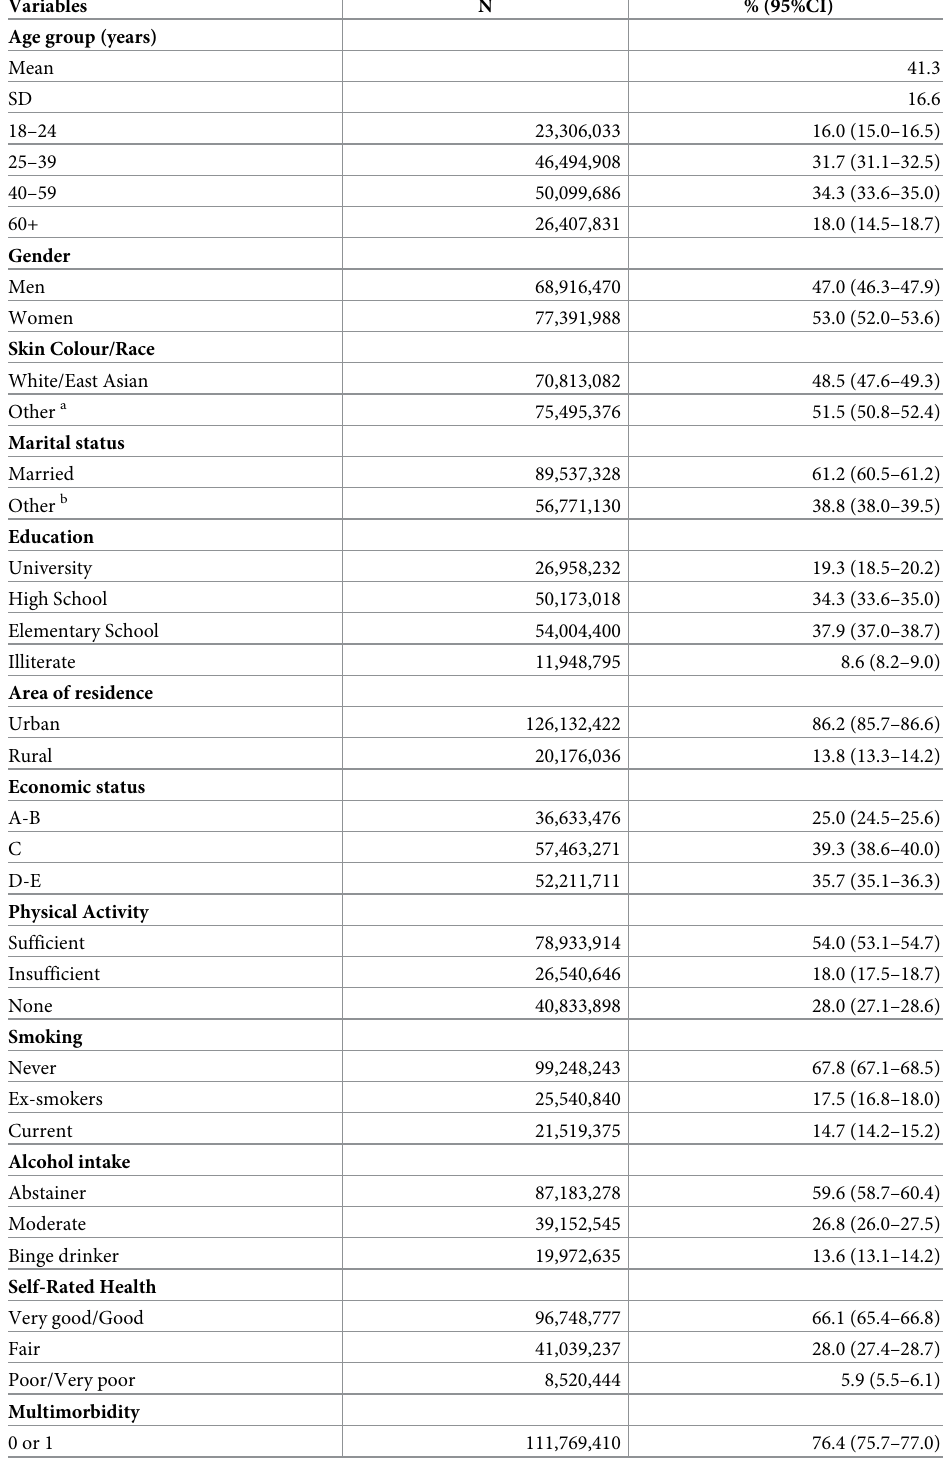
Table 1. Estimated population size (N = 146,308,458), prevalence (% per column), and confidence intervals (95% CI) of helath, lifestyle and sociodemographic characteristics in Brazilian